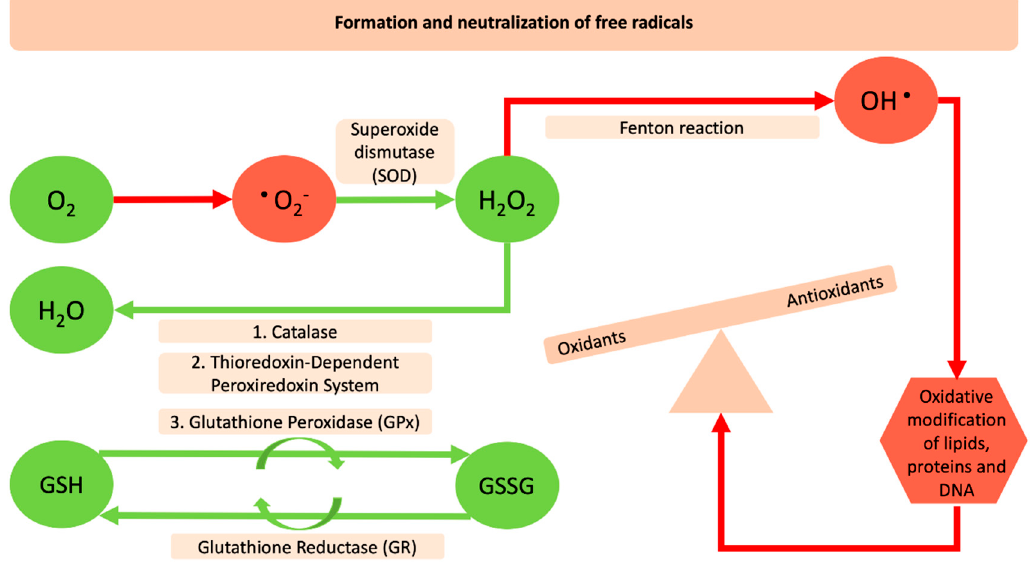
Figure 1. Formation and neutralization of free radicals. The red arrows and red shapes indicate the harmful reactive oxygen species and their negative impact on the oxidation of macromolecules. The green arrows and shapes indicate the antioxidant enzymes and the reactions that counteract and neutralize oxidants.